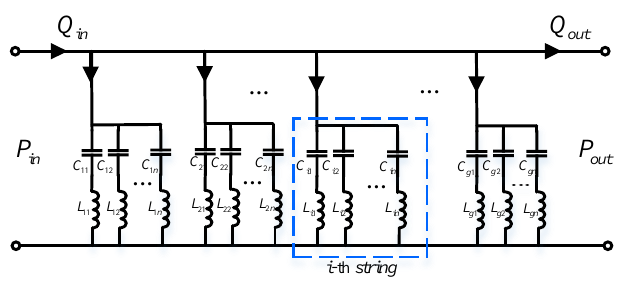
Figure 3. Equivalent circuit of the string array in the RSHPA.